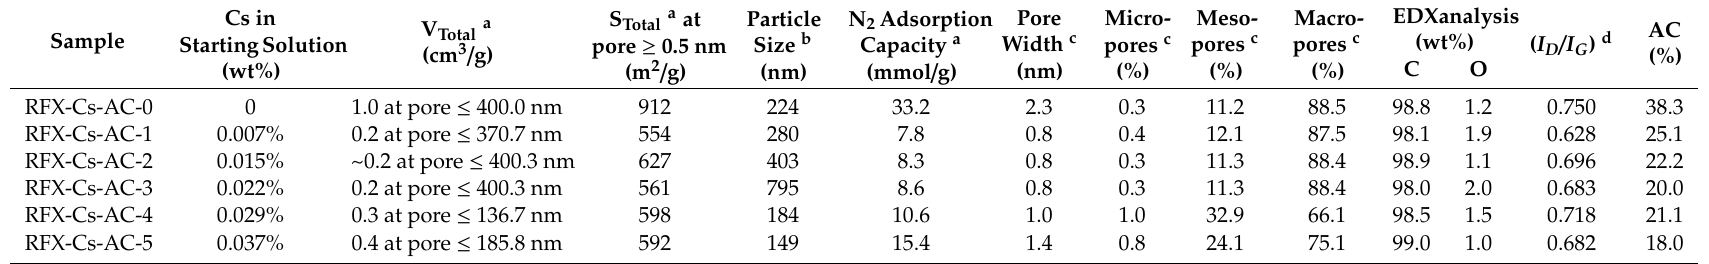
Table 1. Structural characteristics of resorcinol / formaldehyde xerogel activated carbon with chitosan (RFX-Cs-AC)